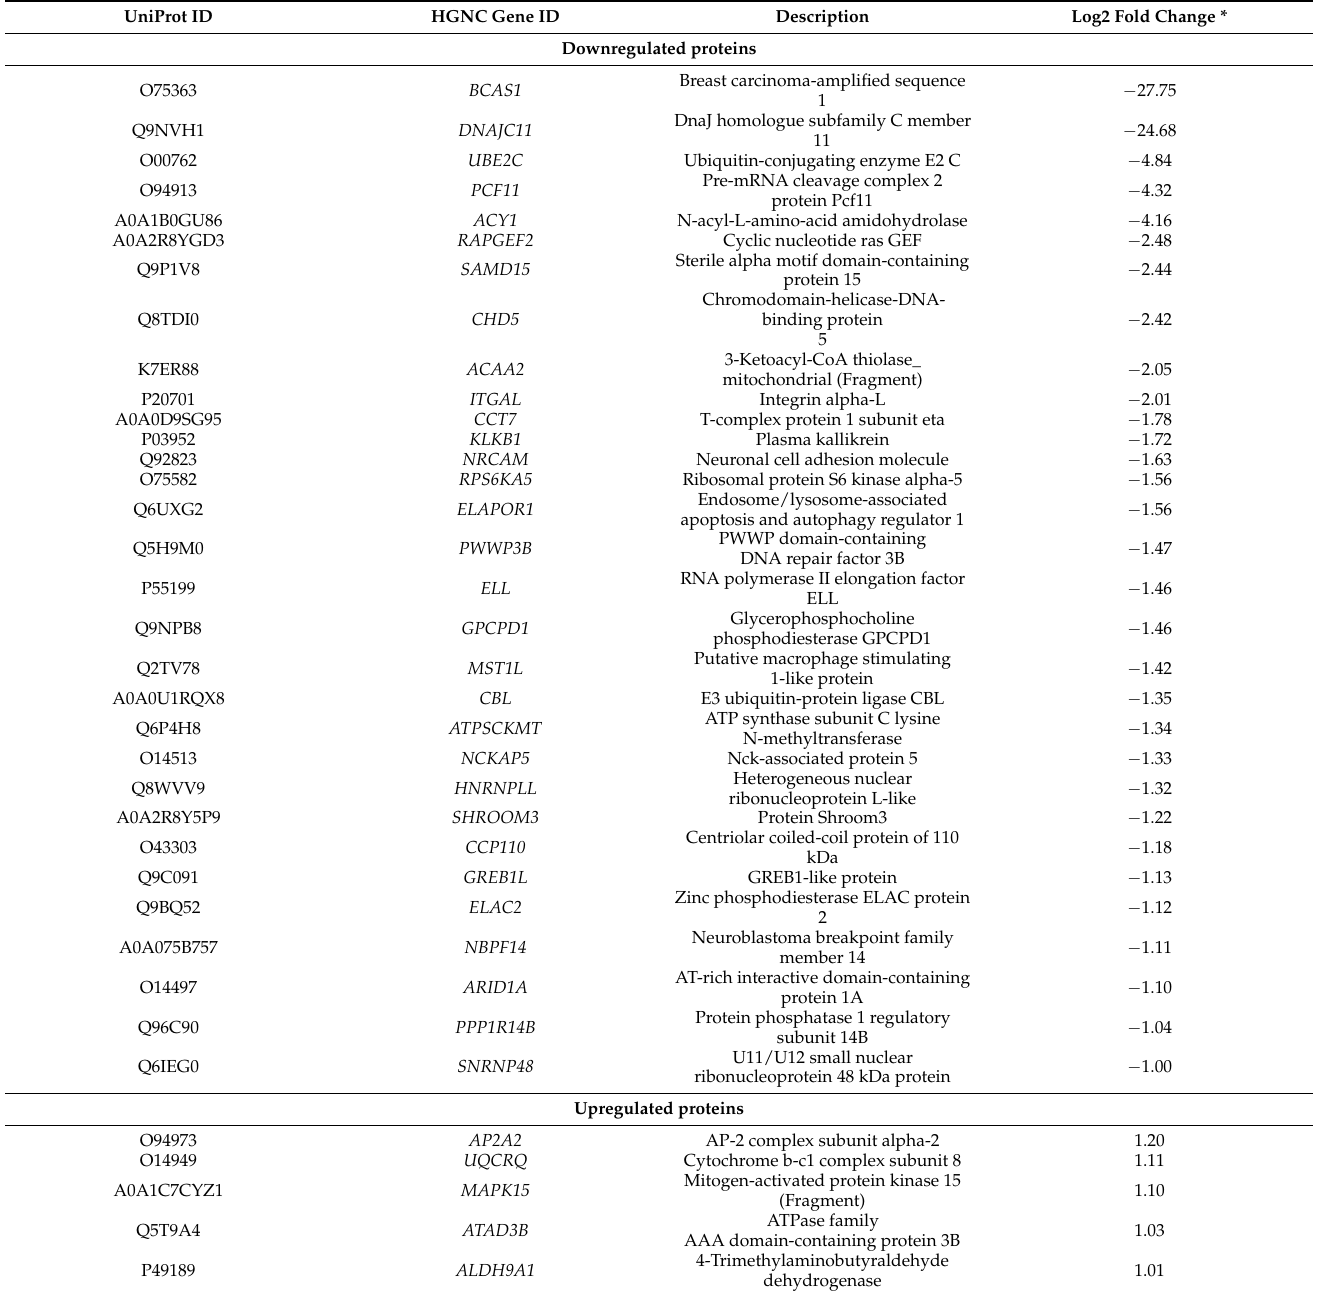
Table 4. Significantly downregulated proteins in CSN38-treated MCF7 cells compared to the monotherapies. UniProt